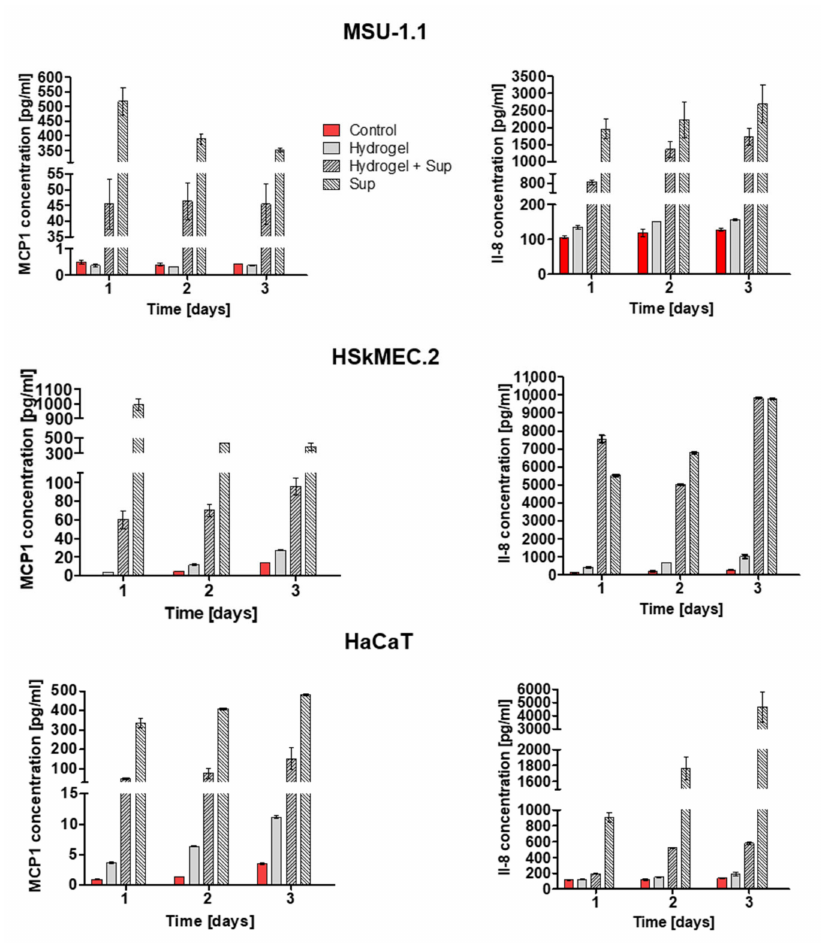
Figure 6. Release of HATMSC2 supernatant-present proteins MCP-1 and IL-8 measured by ELISA. The concentration of MCP-1 (LH panel) and IL-8 (RH panel) measured in culture medium collected from MSU-1.1, HSkMEC.2 and HaCaT cells alone, treated with empty hydrogel, supernatant-loaded hydrogel and 22 µ g supernatant following 1, 2 and 3 days culture in serum-free medium and 1% O 2 . Data represent pulled values from three independent experiments with mean ± SD from two technical